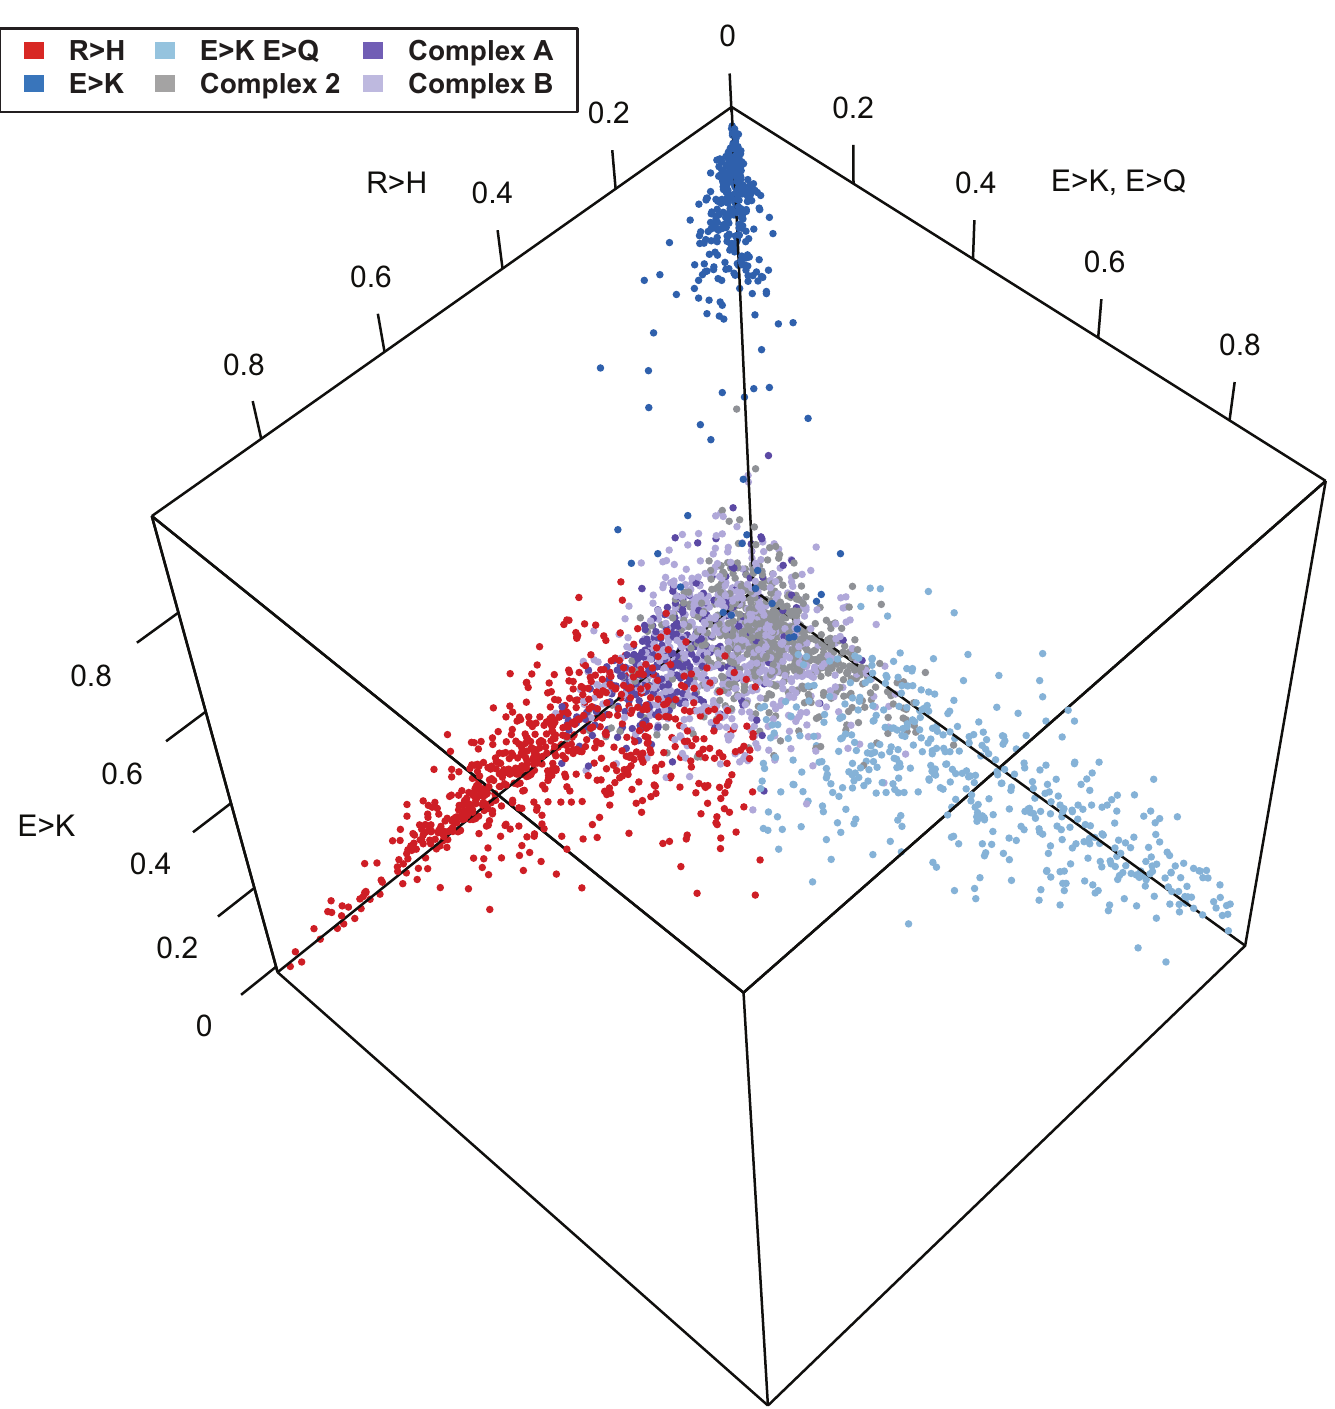
Fig 3. Normalized NMF mixture coefficients for individual samples. Plot of the normalized mixture coefficients across the three mutation signatures with high R > H or E > K componentsfor every individualsample. Colors represent the greatest contributing mutation signature for each sample basedon the full individual-level NMF analysis. Here we see a dramatic separation of samples in the E > K componentto the near exclusionof other signatures.